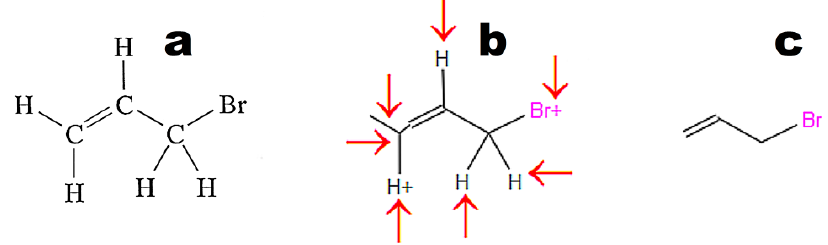
Figure 4. Molecular structure converted by OSRA (structure b in Figure 3): ( a ) original structure; ( b ) structure recognized by OSRA and displayed in a molecule editor (arrows indicate fragments that require curation); ( c ) structure after curation in a molecule editor.